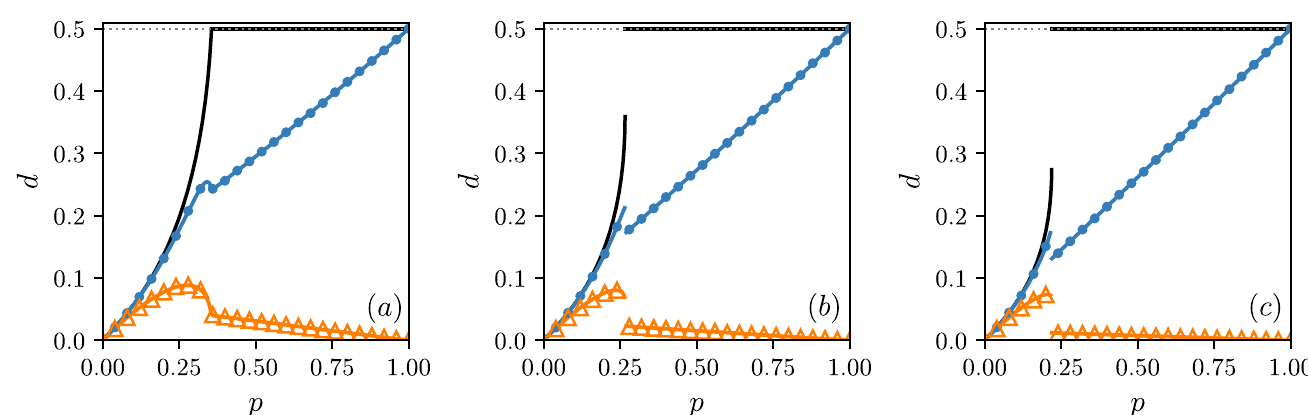
Fig 2. Stationary value of the dissonance level as a function of independence. Results for different q -panel sizes are presented: (a) q = 4, (b) q = 5 and (c) q = 6. Analytical results are marked by lines: black lines, which do not overlap symbols, are obtained under the assumption that private and public opinions are independent, i.e., by Eq (12), whereas lines that overlap symbols are obtained from the exact analytical approach. Symbols illustrate outcomes from Monte Carlo simulations: 4 for the TA (think then act) and • for the AT (act then think) models. The initial state of the system is the ordered one. As seen, the level of dissonance for the AT model is higher that for the TA model. Results from Monte Carlo simulations have been obtained for the system of the size N = 10 5 averaged over 100 samples after 10 5 MCS.